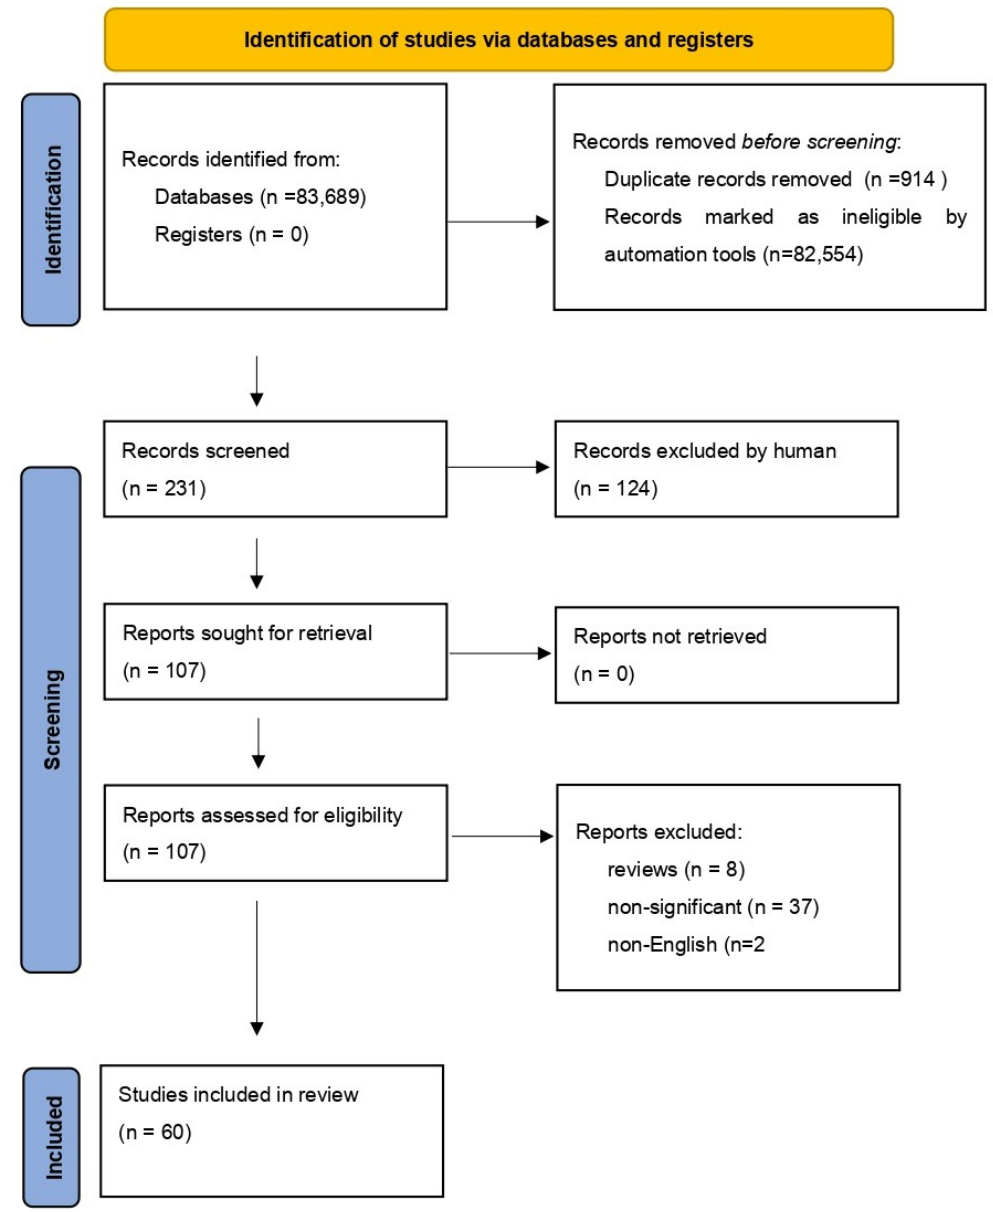
Figure 2. The PRISMA Flow